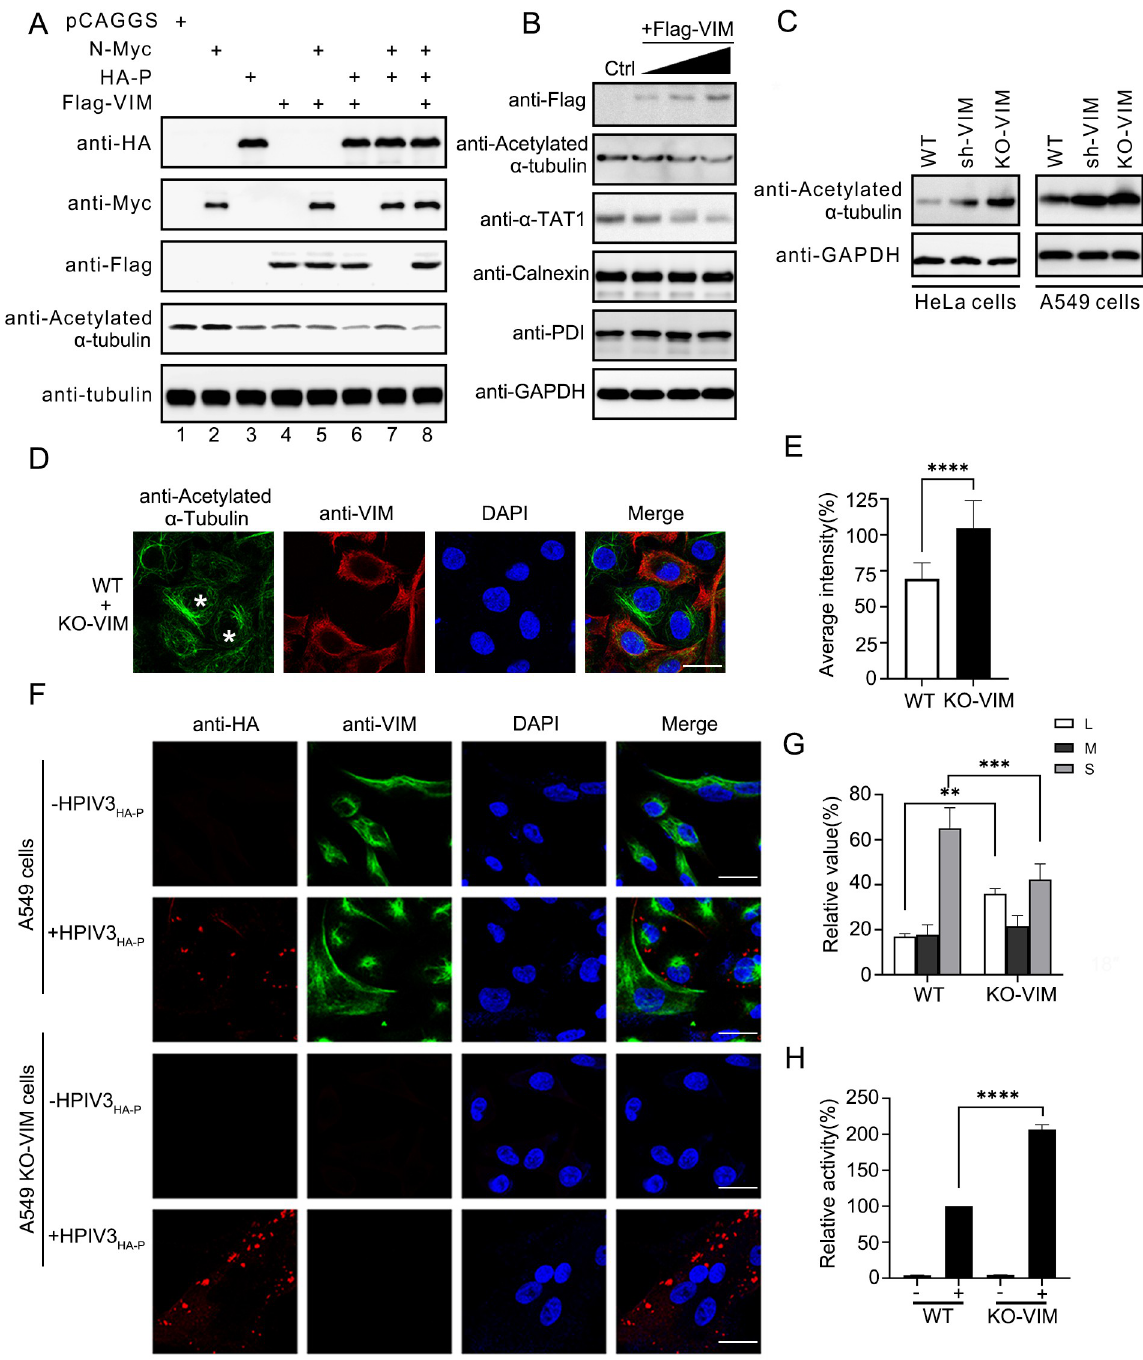
Fig 4. VIM negatively regulates the acetylation of α -tubulin, inhibiting the formation of HPIV3 IBs. (A) VIM downregulated α -tubulin acetylation. N-Myc, HA–P, and Flag–VIM plasmids were transfected alone or together, and the acetylation of α -tubulin was detected as well as the overexpressed proteins. (B) VIM downregulated the α -TAT1 protein level and the acetylation of α -tubulin. The expression of VIM protein in HeLa cells was gradually increased. The protein level of α -TAT1 and acetylation of α -tubulin were detected. Two endoplasmic reticulum proteins, calnexin and PDI, were also detected. (C) Acetylation level of α -tubulin in KD and VIM-KO cells. Acetylation of α -tubulin in WT/ VIM-KD/VIM-KO cells (HeLa/A549) was detected. (D) Acetylated α -tubulin morphology in WT and VIM-KO cells. WT A549 and KO-VIM A549 cells were mixed (1:1), and the acetylated α -tubulin was detected using specific antibodies in the IF assay. Scale bar: 20 μ m. (E) Fluorescence intensity of acetylated α -tubulin in (D) was analyzed using ImageJ, and the results are shown in the histogram with difference analysis. Ten visible fields of cells were observed and analyzed. (F) HPIV3 viral IBs fused to increase in size in the VIM-KO A549 cells,